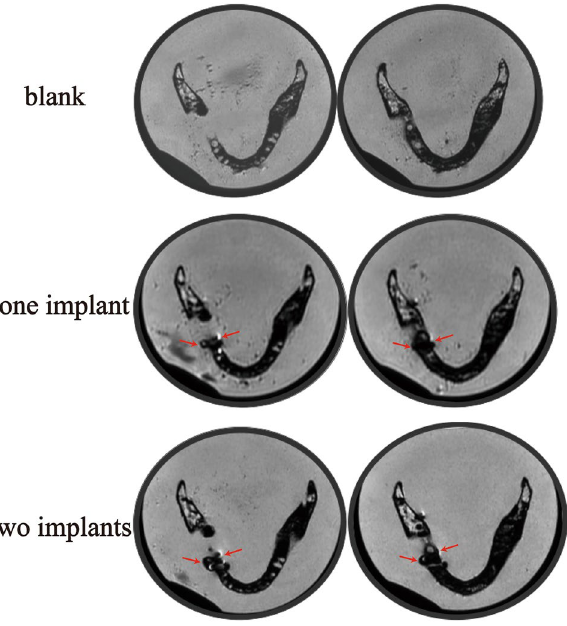
Figure 5. Susceptibility artifacts generated by titanium implants in a dry human mandible FRFSE-T2WI (red arrows indicate the artifacts).